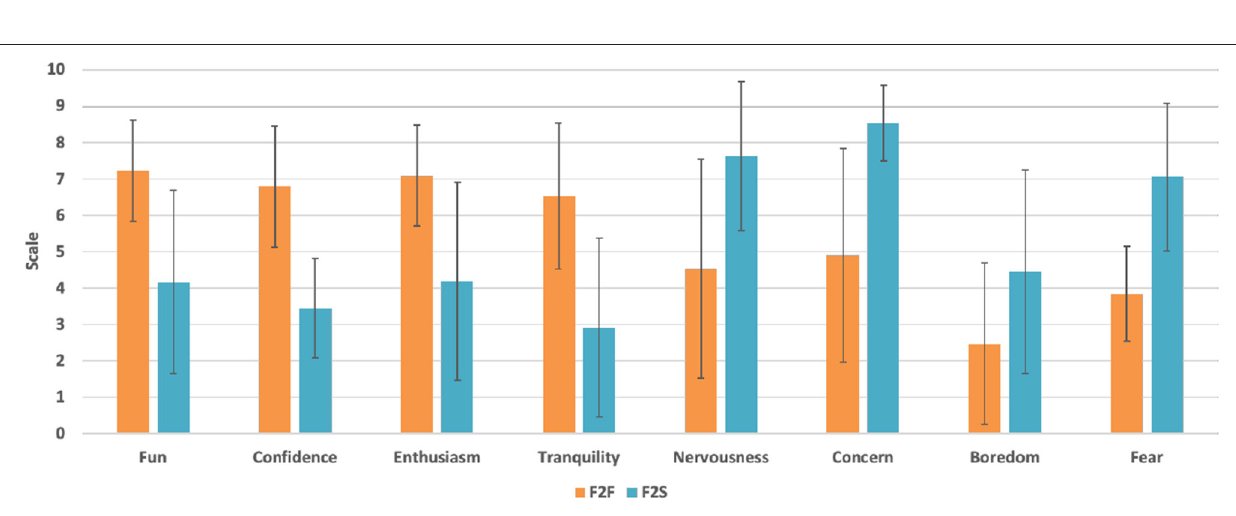
TABLE 6 | Emotion comparison between F2F and F2S flipped instruction methodology.